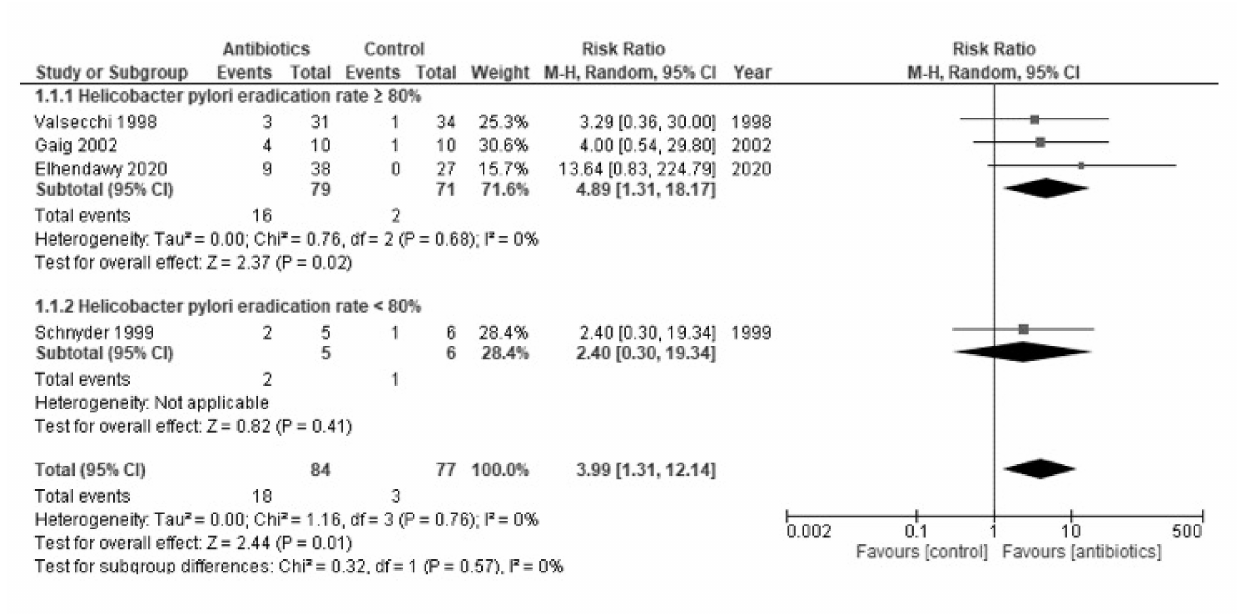
Figure A1. Forest plot of the remission rate with H. pylori eradication rate: ≥ 80% versus